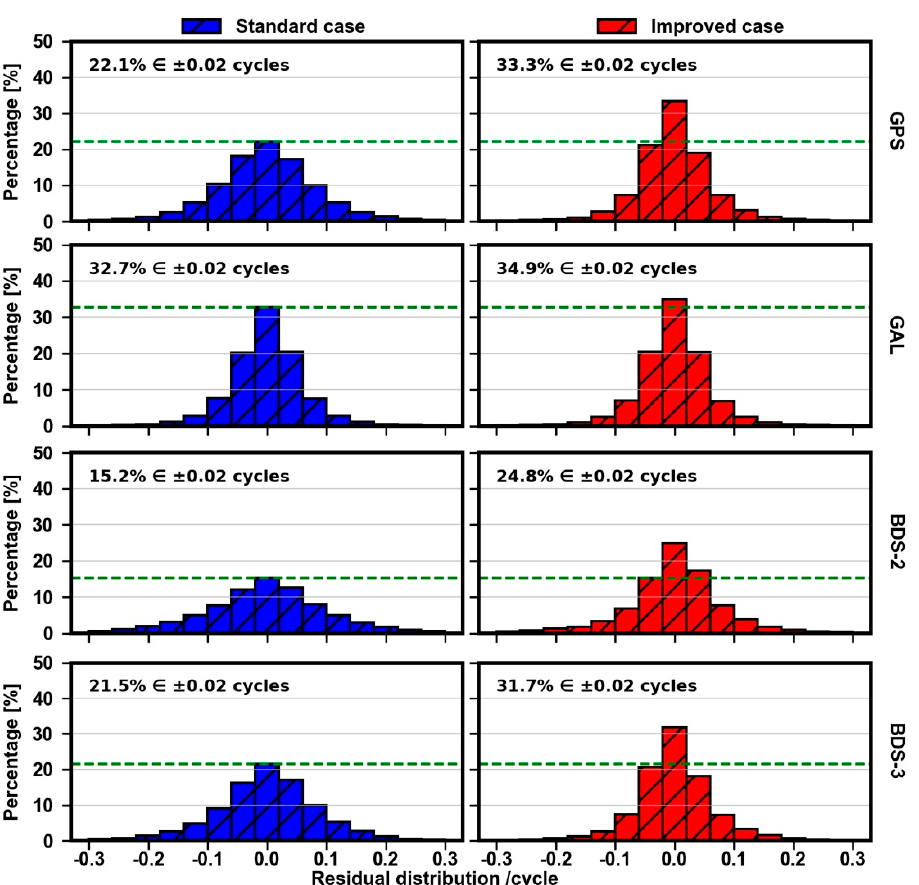
Figure 14. Residual distributions of WL ambiguities for the standard case and improved case for the Case 4